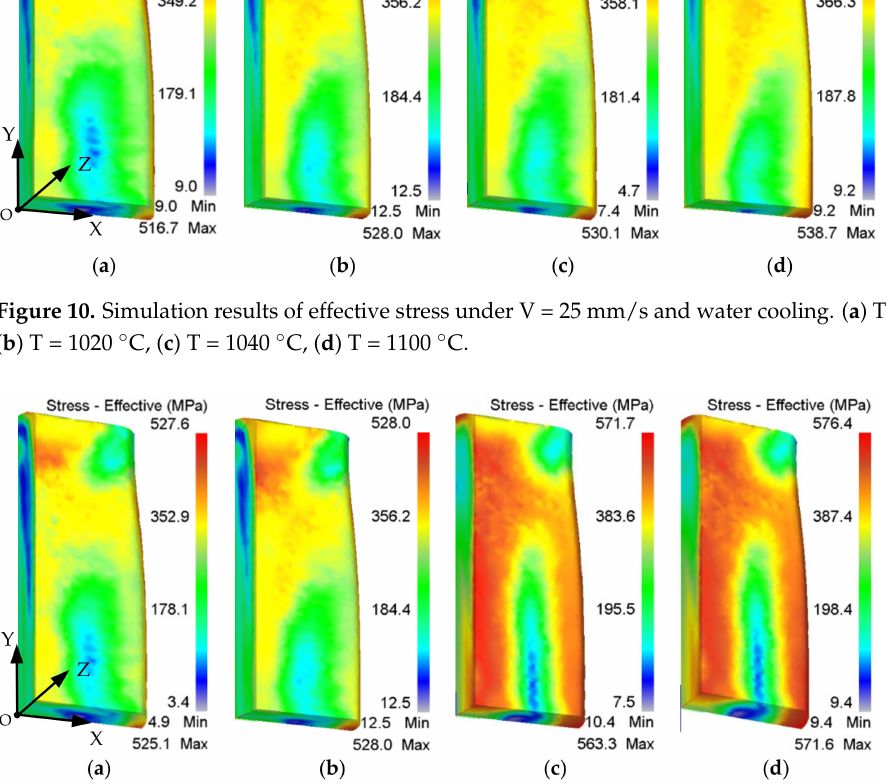
Figure 11. Simulation results of effective stress under T = 1020 ◦ C and water cooling. ( a ) V = 5 mm/s, ( b ) V = 25 mm/s, ( c ) V = 50 mm/s, ( d ) V = 100